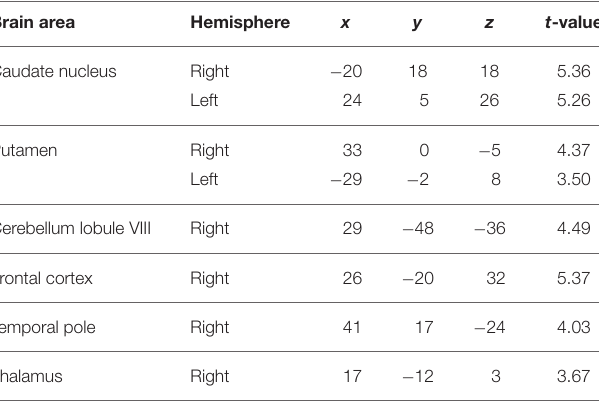
Table 1B | Brain areas whose activity decreased as a function of jitter.